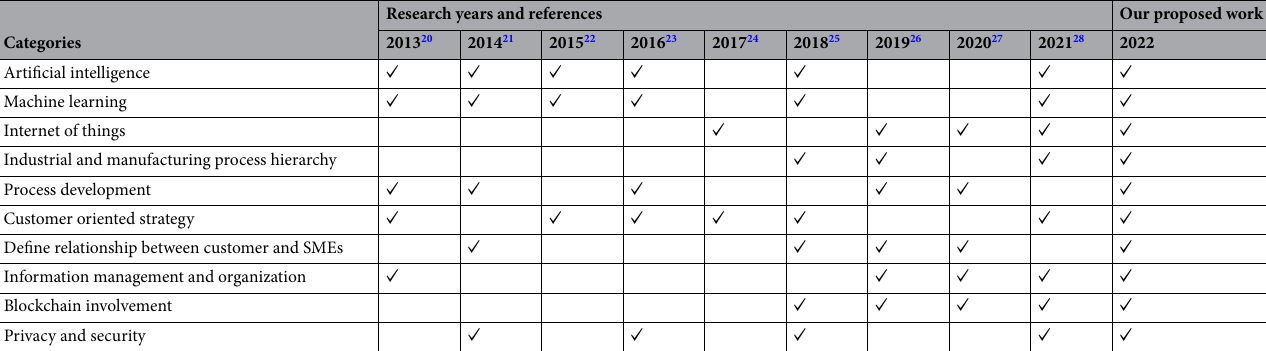
Table 2. Systematic review of the